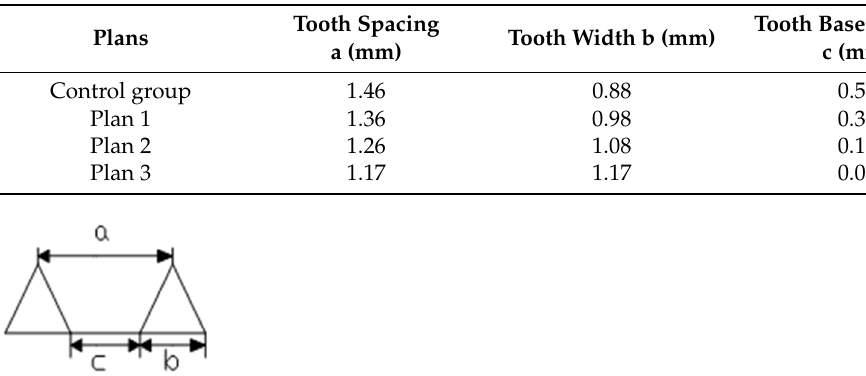
Table 3. Channel physical optimization plans of the emitter.